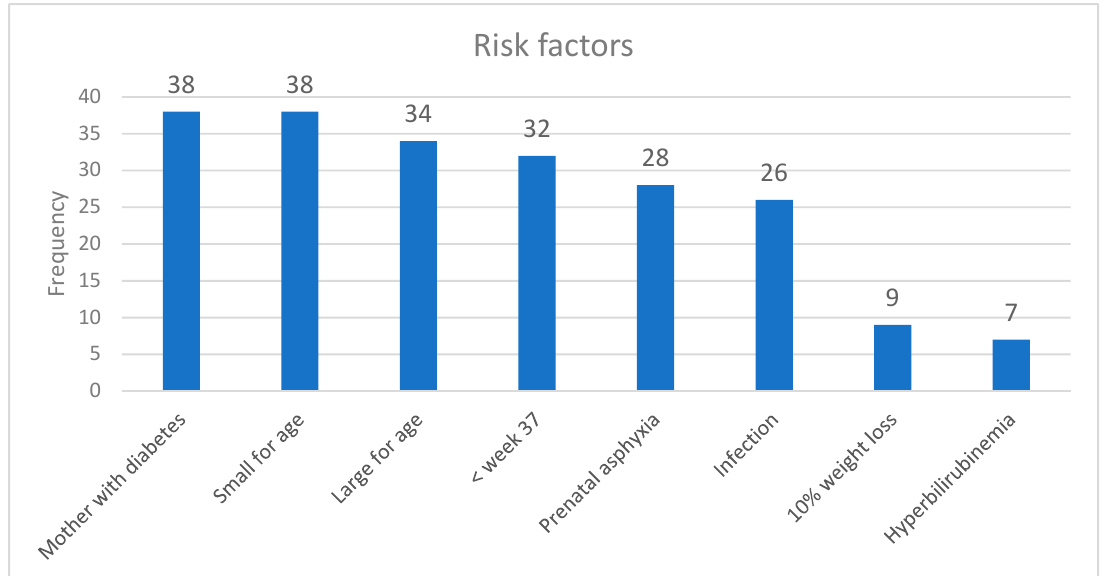
Figure 1. Feeding methods for supplemental feeding.